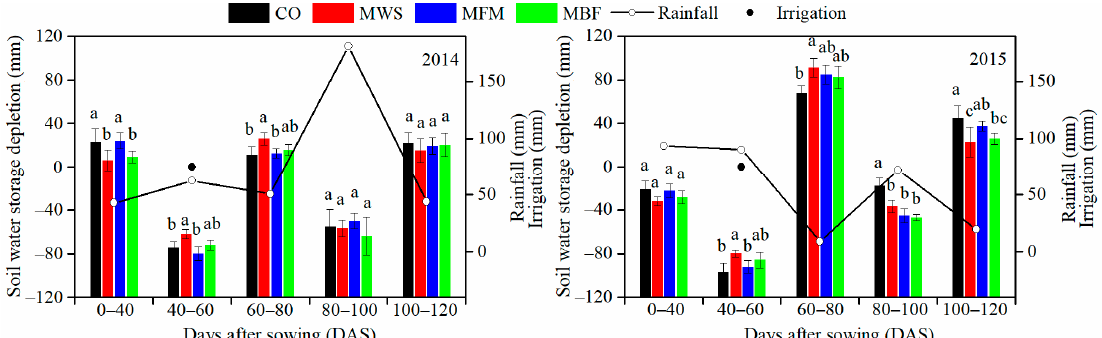
Figure 4. The soil water storage depletion (SWSD) in the 0–100 cm layers under indicated treatments during the different maize growth stages in 2014 and 2015. The abbreviations of the treatment names are the same as those described in Figure 2. Means of the SWSD within the same growth stage sharing the different lowercase letters are significantly different at p < 0.05.